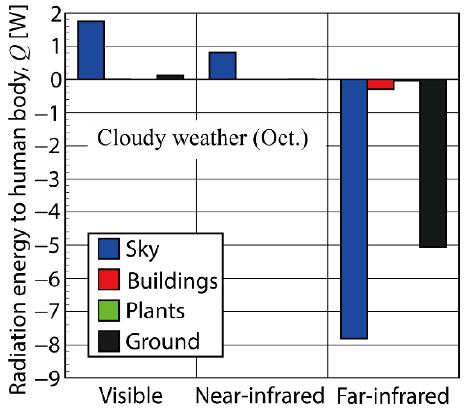
Figure 14. Calculated radiation energy to human body in cloudy weather experiment at the Imperial Palace.